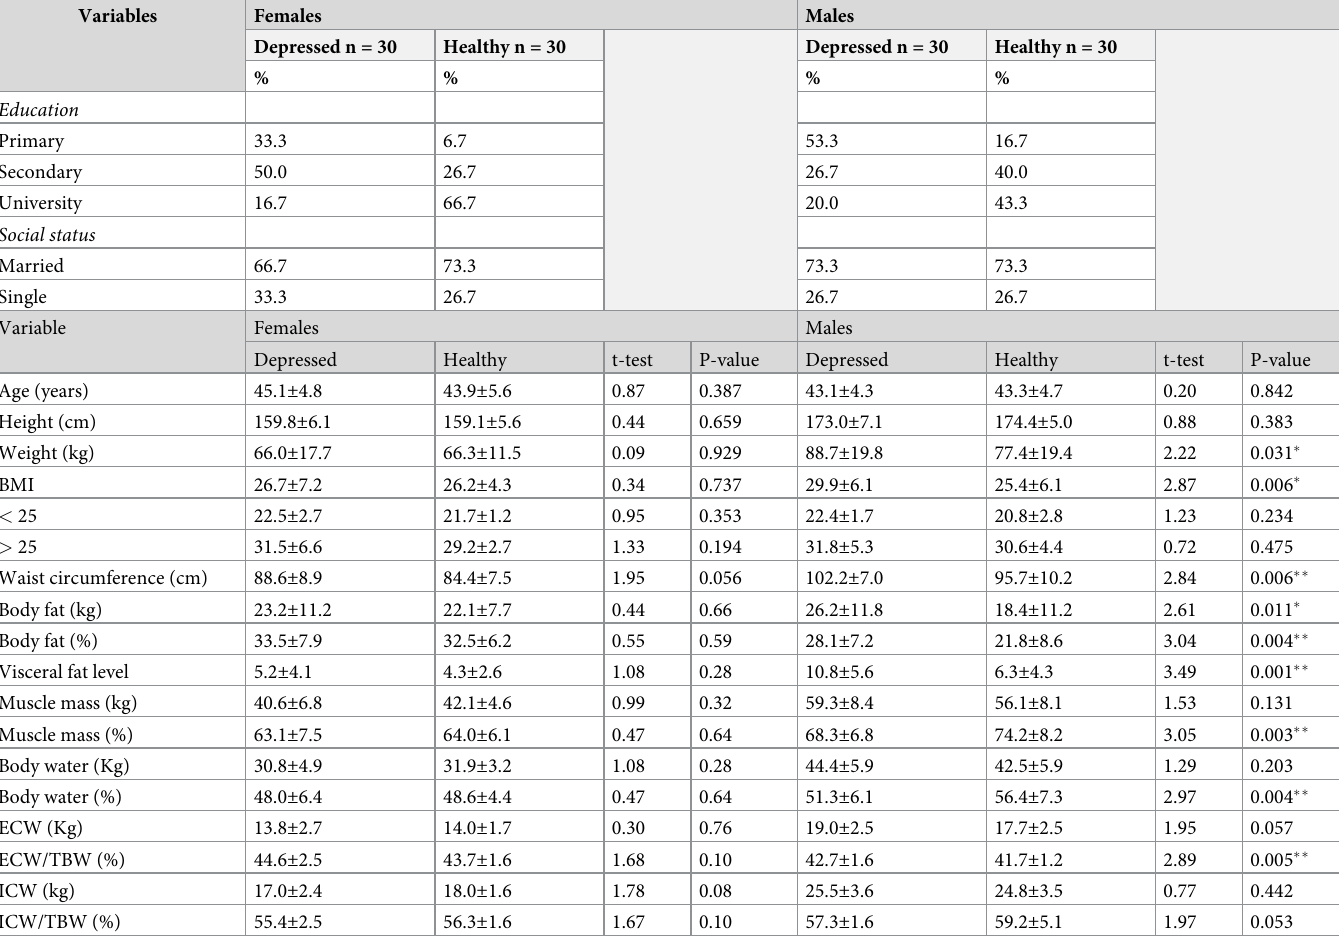
Table 1. Demographic characteristics and anthropometric proxies of depressed and healthy females and males